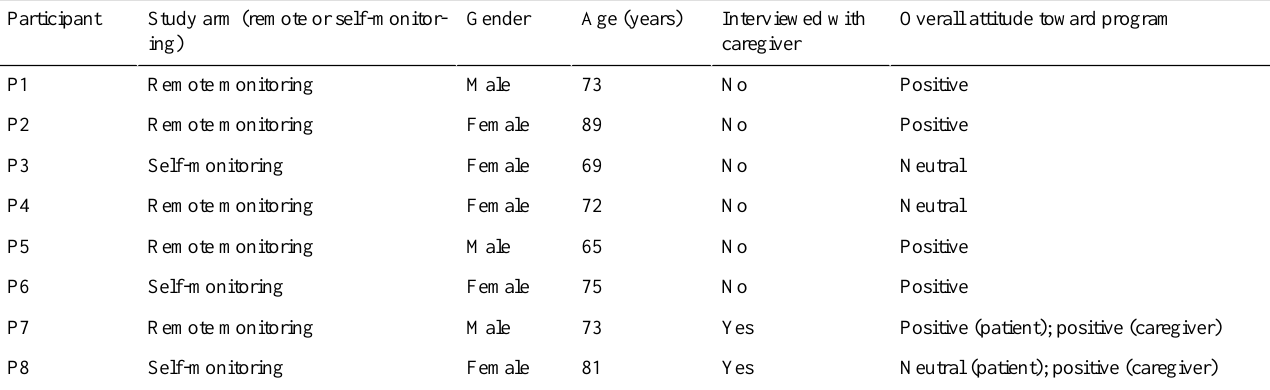
Table 2. Patients and caregivers who